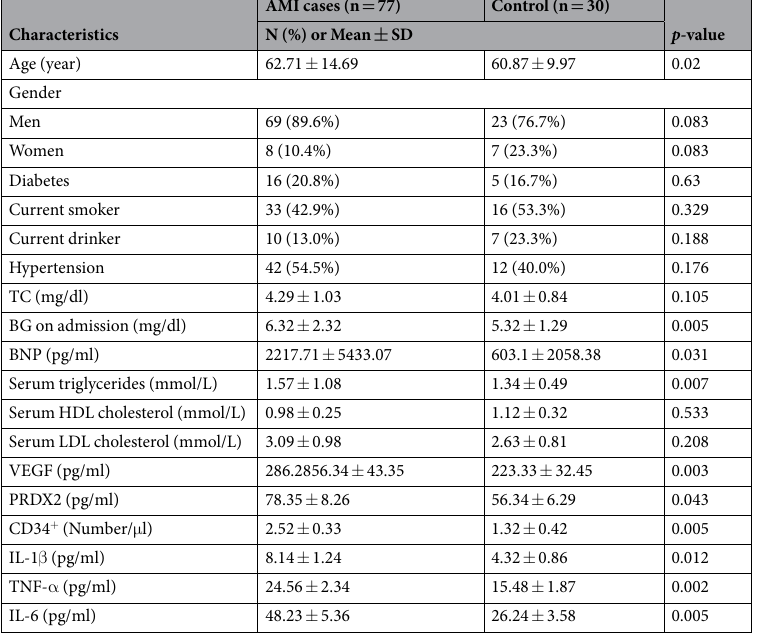
Table 1. Demographic characteristics and serum cytokine levels of AMI cases and controls. Values are mean ± SD, p < 0.05 means that the difference between two groups are significant. AMI, acute myocardial infarction; TC, total cholesterol; HDL-C, high-density lipoprotein cholesterol; BG, blood glucose; BNP, brain natriuretic peptide; PRDX2, peroxiredoxin 2; VEGF, Vascular Endothelial Growth Factor; IL-1 β , Interleukin-1 β ; TNF- α , tumor necrosis factor- α ; IL-6,